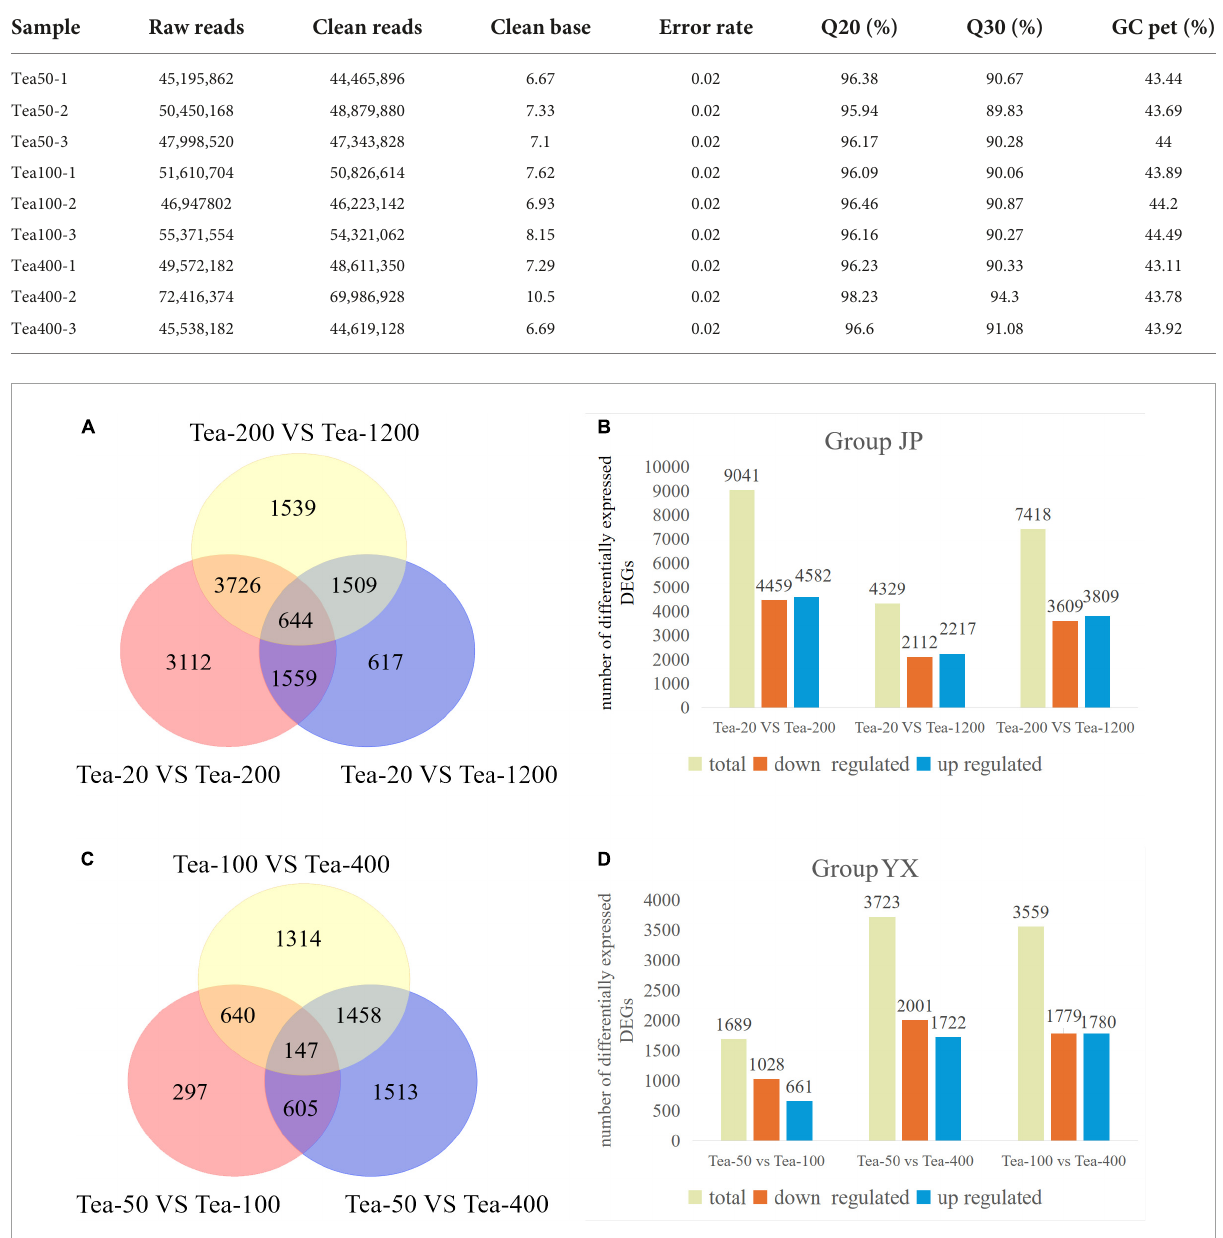
FIGURE2 Venn diagram and column diagram of differentially expressed genes in fresh tea leaves of groups JP and YX. (A,B) Group JP; (C,D) Group